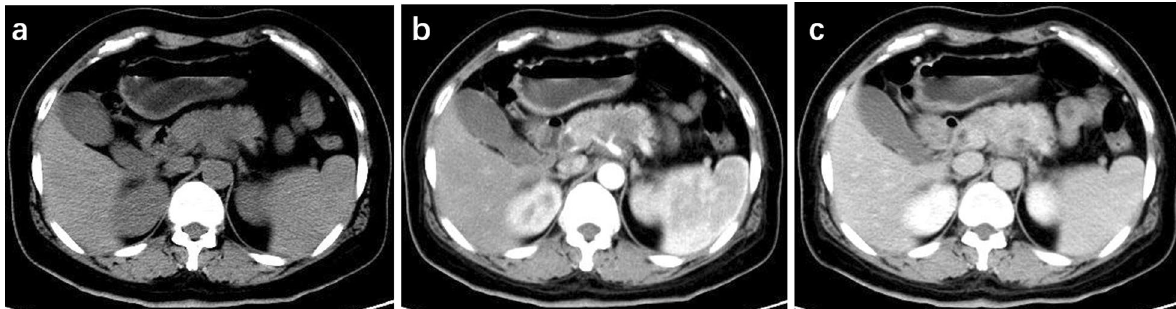
Fig. 3 PDAC of the pancreatic body in a 51-year-old woman. a Unenhanced CT scan shows an ill-defined solid mass with a size of 4 cm. The CT value of the tumor is 36 HU. b Arterial phase CT scan shows diffusely mild homogeneous enhancement of the lesion and the celiac trunk is involved. The CT value of the tumor is 45 HU. c Portal phase CT scan show s progressively filling enhancement. The CT value of the tumor is 61 HU